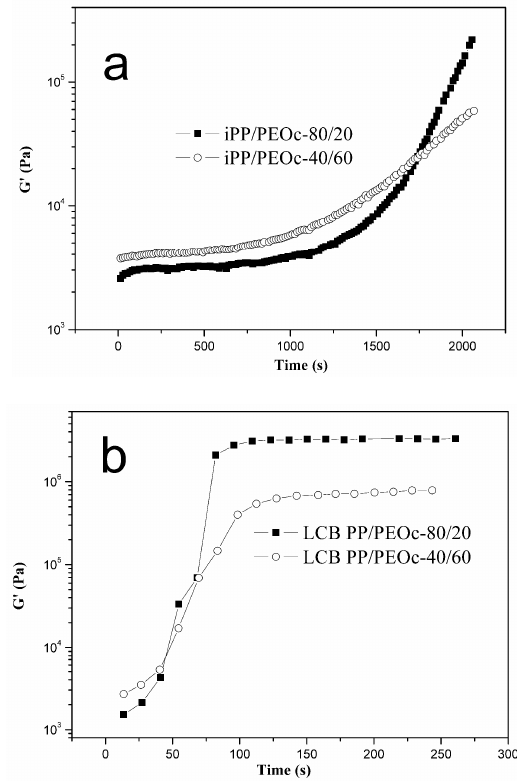
Figure 3. Storage modulus development curves at 140 °C for ( a ) iPP/PEOc-80/20 and iPP/PEOc-40/60; and ( b ) LCB PP/PEOc-80/20 and LCB PP/PEOc-40/60 blends.